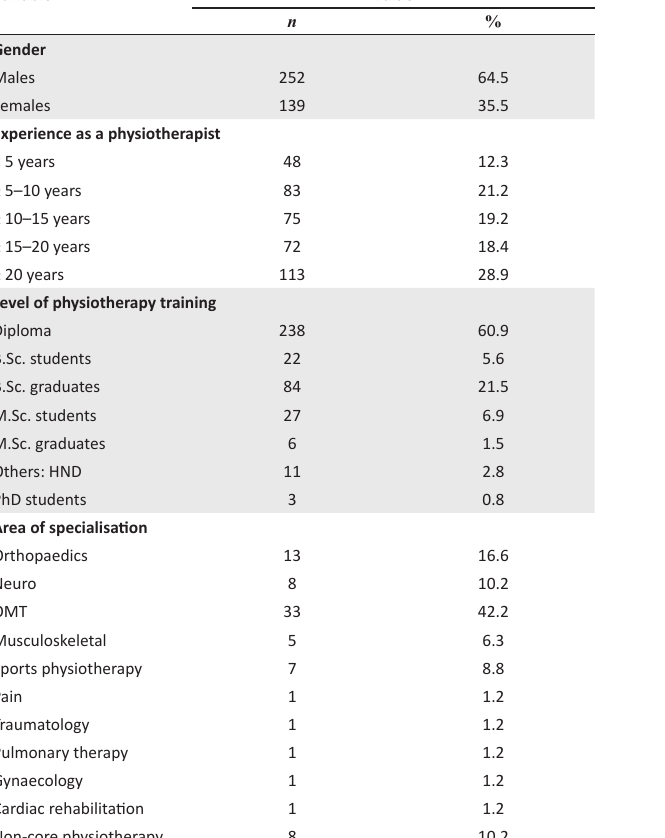
TABLE 1: Gender, experience, level of training and area of specialisation ( n = 391). Variable